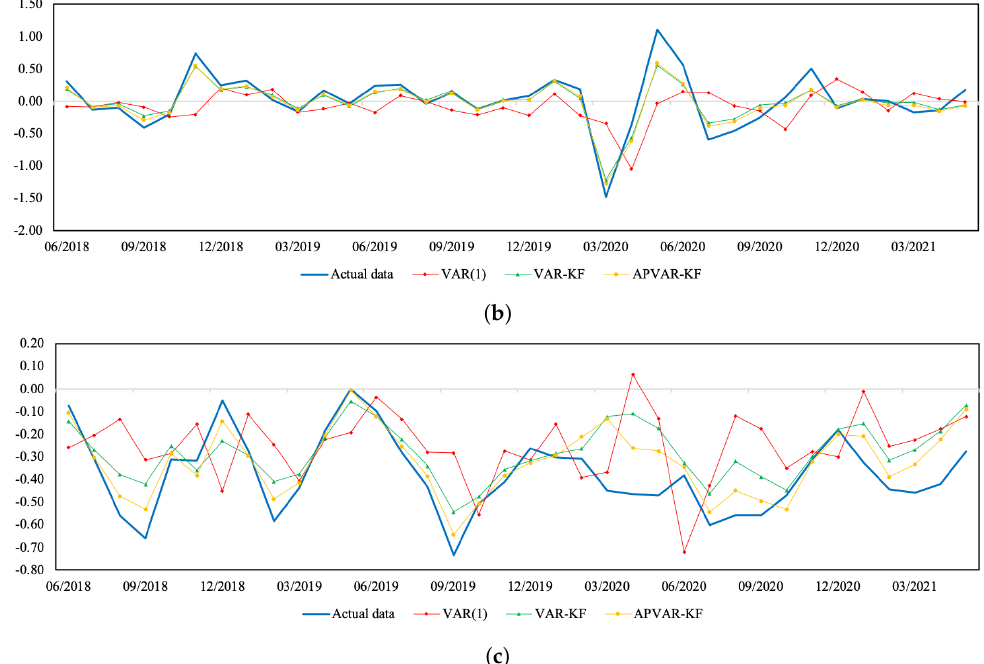
Figure 2. A comparison between the actual data and the estimated values from three methods for Indonesia during July 2018–May 2021. ( a ) Normalized JKSE index return; ( b ) normalized real effective exchange rate return; ( c ) normalized CPI